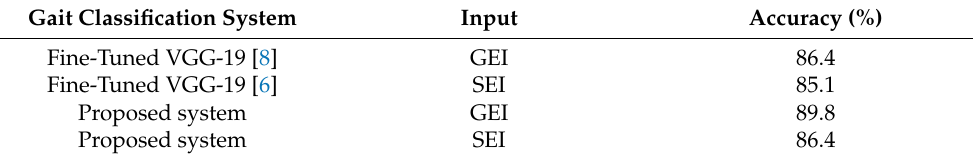
Table 3. Cross-dataset results obtained using GAIT-IT for training and GAIT-IST for testing. Gait Classification System